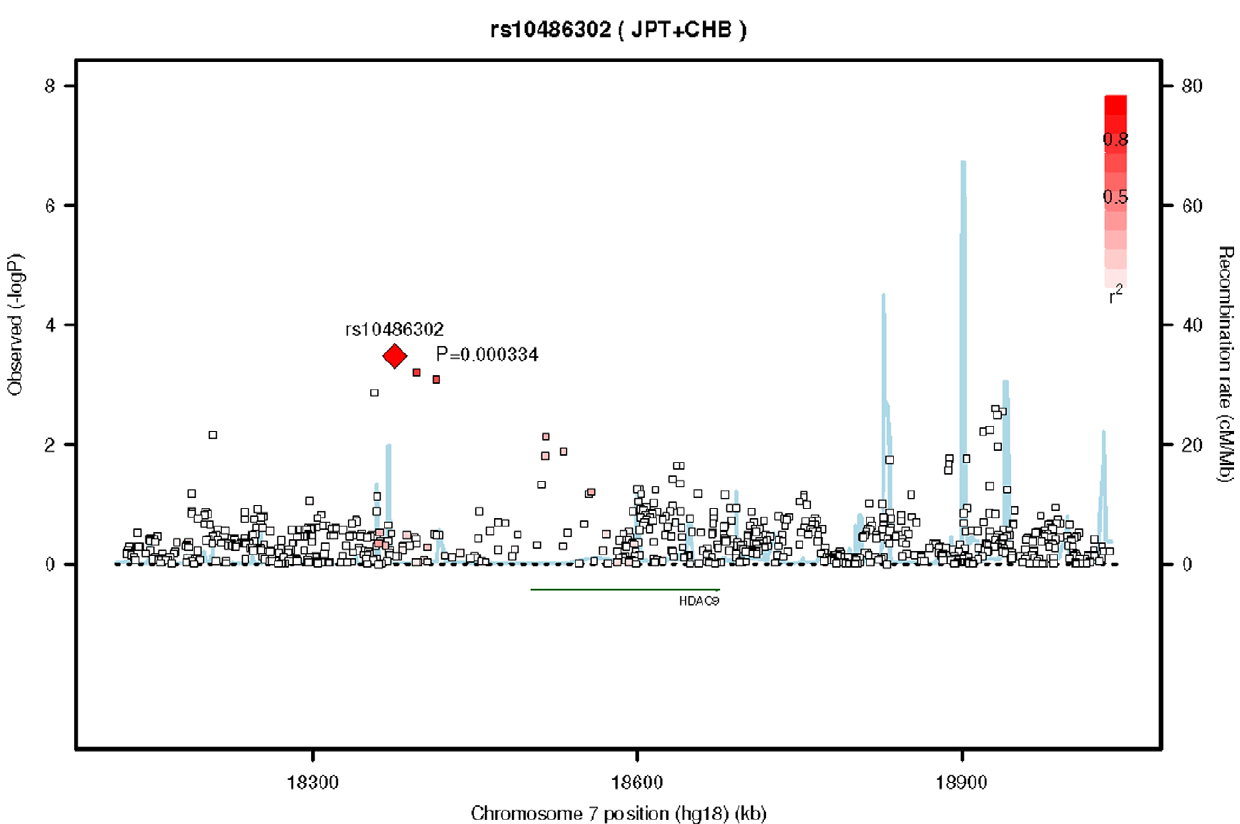
Figure 3. Regional association plot of SNP rs10486302 on chromosome 7 for Singapore Asian Indians. This figure is the regional association plot of SNP rs10486302 on chromosome 7 that reached gene-wide significance (p , 4.9 6 10 2 4 ) in the testing of transferability of the discovery SNP, rs12155400, to other SNPs in the histone deacetylase 9 gene in a cohort of Singapore Asian Indians without diabetes or hypertension. The lead and surrounding SNPs are color coded according to the pair-wise linkage disequilibrium (LD) with the lead SNP (presented as a diamond) on a scale of r 2 from 0 to 1. Estimated recombination rates reflect the local LD structure in the 500kb buffer around the index SNP and plotted based on values from HapMap II Han Chinese of Beijing China (HCT)/Japanese in Tokyo, Japan (JPT) populations.